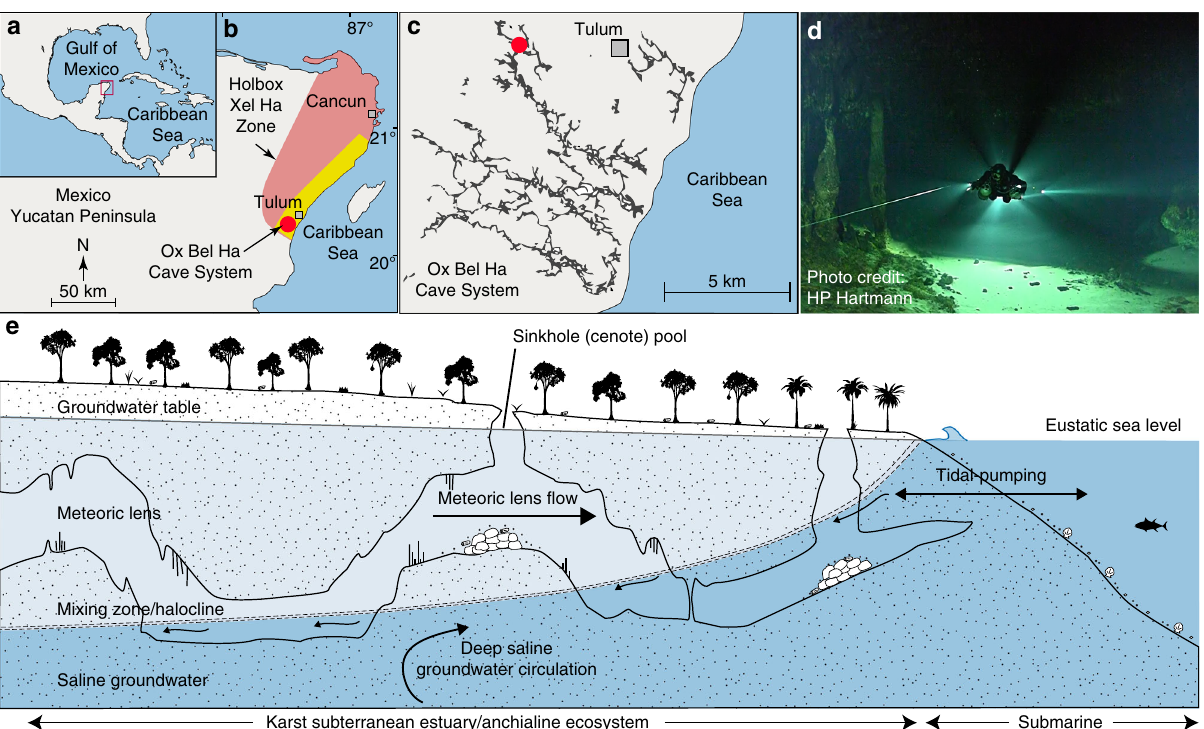
Fig. 1 Study site and model for coastal karst subterranean estuary. a The Yucatan Peninsula. b In the Yucatan Peninsula (Mexico), coastal cave systems extend 12 km inland (yellow area) and cover an area of ~1100 km 2 within the Holbox Fracture Zone and Xel Ha Zone (red area) — adapted from Perry et al. 16 c Mapped cave conduits of Ox Bel Ha Cave System ( > 240 km total length) 27 . Cenote Bang, the primary study site, is indicated by the red circle. d Cave diver within cave system Cenote Bang. e Conceptual model of a tropical karst subterranean estuary, a density-strati fi ed coastal aquifer — adapted from van Hengstum et al.